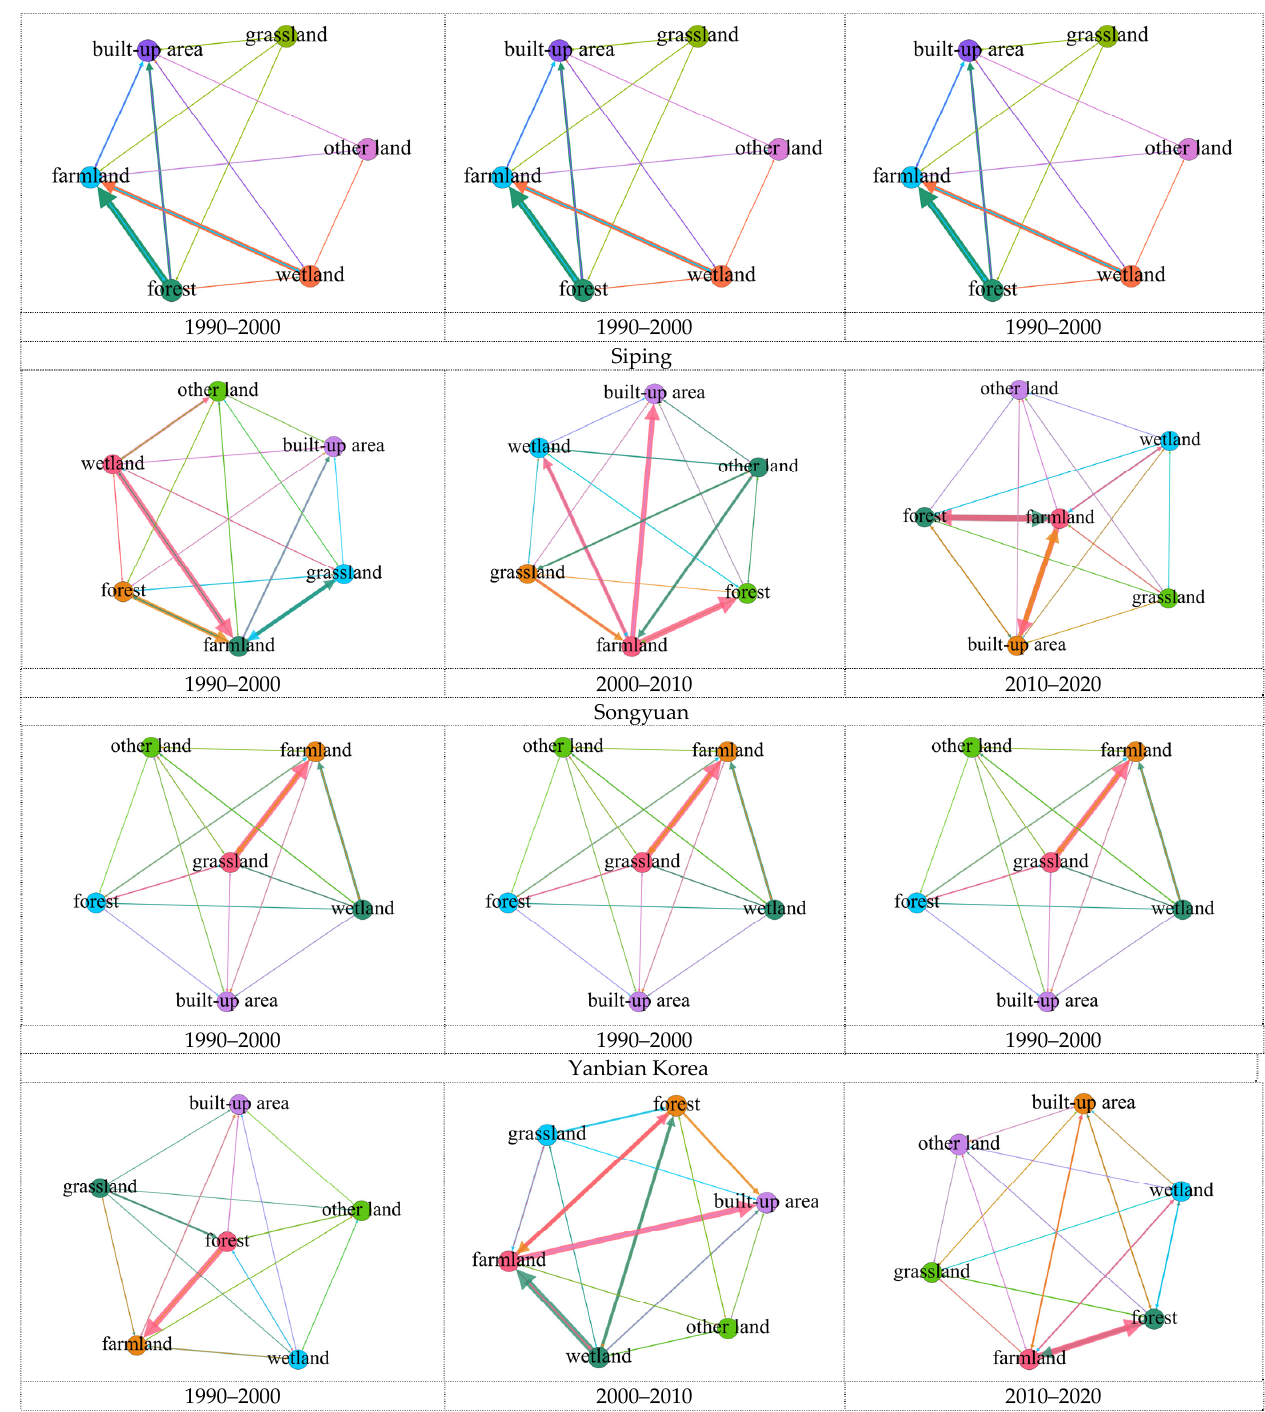
Figure A1. Complex network of land use changes in different periods in different cities.